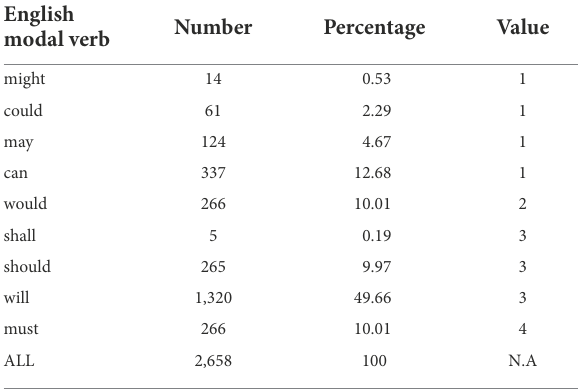
TABLE 5 Frequency of each English modal verb in